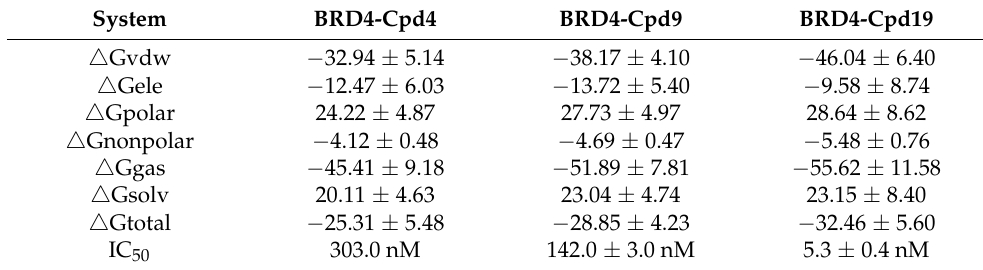
Table 3. MM-GBSA results (kcal/mol).